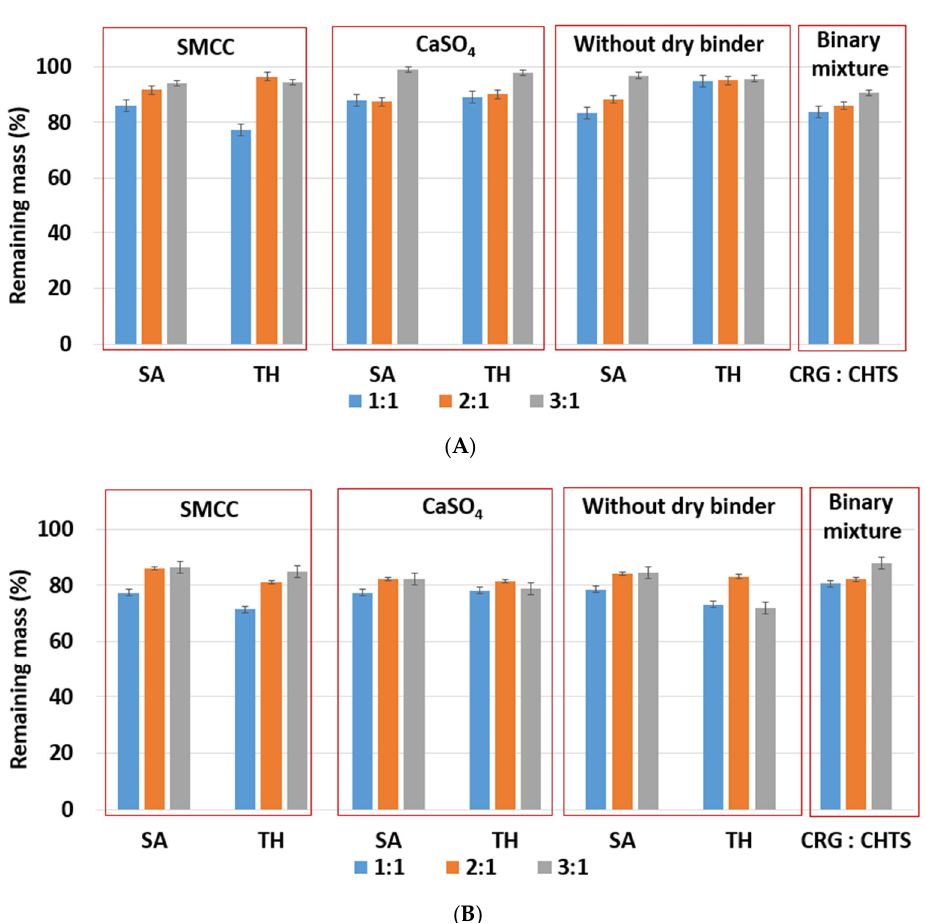
Figure 5. ( A ) The effect of ratio CRG/CHTS (1:1; 2:1; 3:1), type of dry binder (Prosolv ® SMCC 90, CaSO 4 ), and model drug solubility (TH, SA) on the erosion behavior of the studied matrix tablets in acidic medium (2 h). ( B ) The effect of the CRG/CHTS ratio (1:1; 2:1; 3:1), type of dry binder (Prosolv ® SMCC 90, CaSO 4 ) and model drug solubility (TH, SA) on the erosion behavior of the studied matrix tablets in phosphate buffer (2 h in acidic medium then 2h in phosphate buffer).